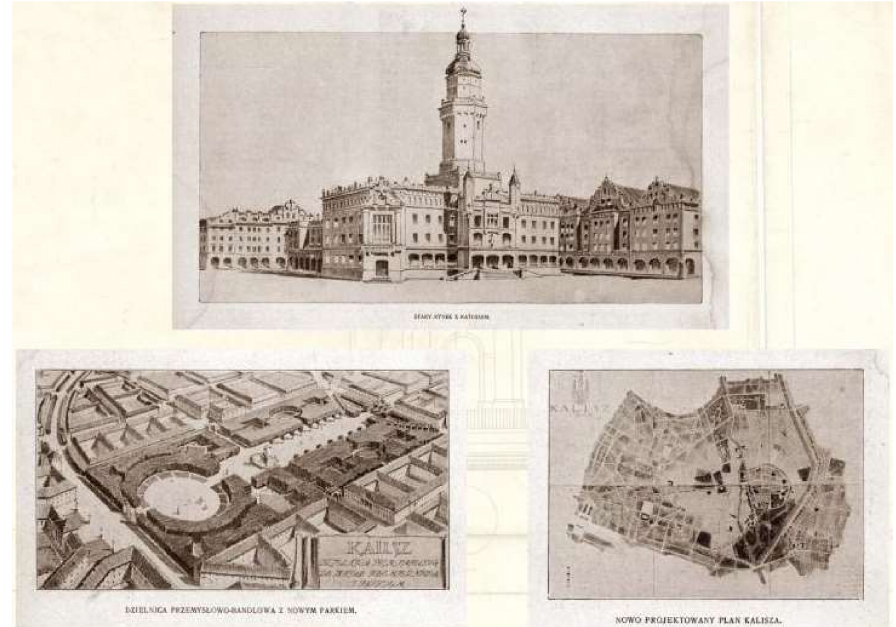
Figure 2. Drawings of the Kalisz reconstruction from Zdzisław Kalinowski’s project, which won second prize in the 1915 Competition [16]. Reproduced with permission from Archiwum Pa´nstwowe w